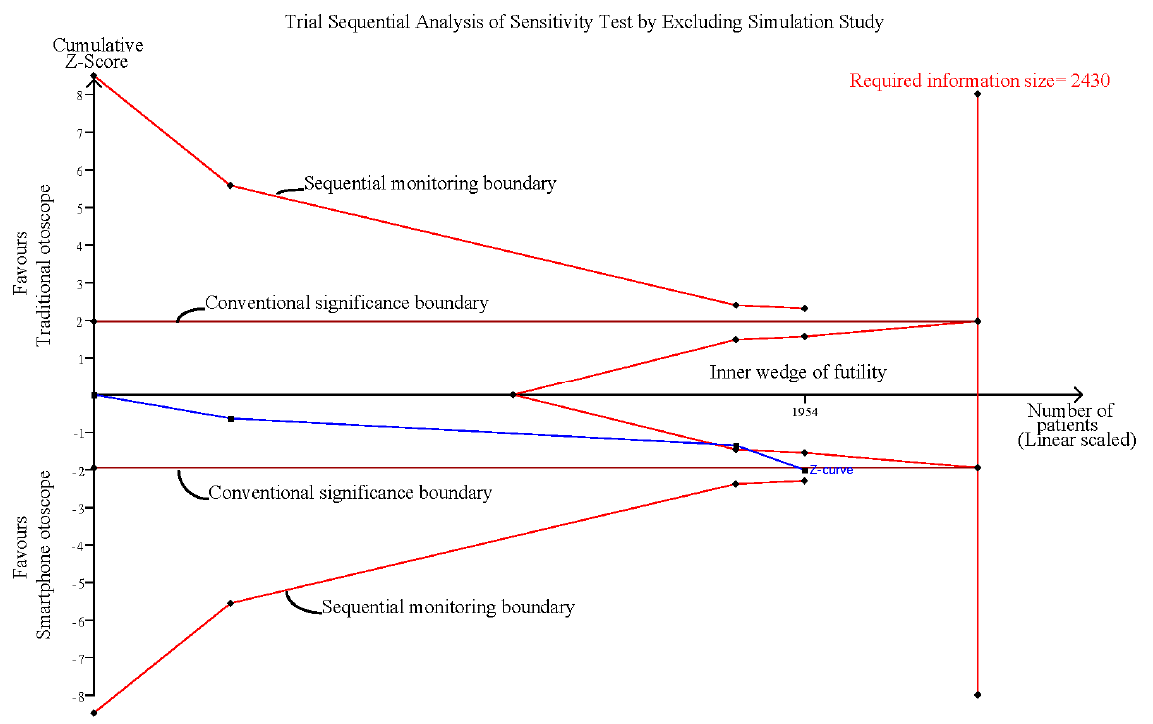
Figure 9. Trial sequential analysis (TSA) of sensitivity analysis by excluding the simulation study.